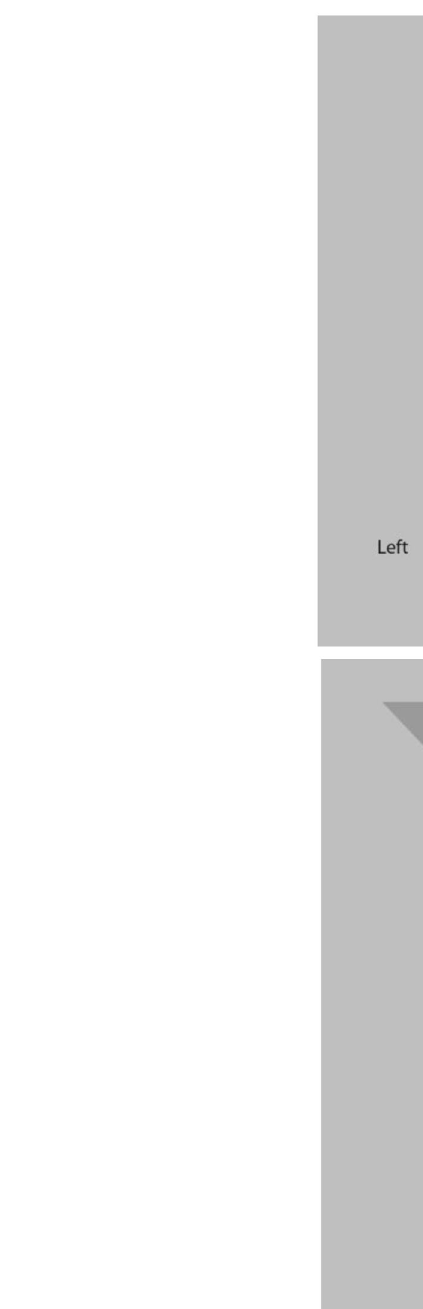
(Bottom) A lesion of the dominant MSO in the right hemisphere causes a left-sided visuo-spatial neglect due to less excitation (“deactivation”) of the ipsilateral visual cortex. This is further suppressed by increased inhibition from the contralateral visual cortex. While the motion-sensitive area MT/V5 receives less input from the ipsilateral visual cortex, it still receives excitatory input from the contralesional MT/V5. Modulation of the left visual cortex could hypothetically result in enhanced visuo-spatial attention within the right hemifield due to the increased activation from the nondominant MSO and less inhibition from the ipsilateral right visual cortex (modified from Brandt et al.,